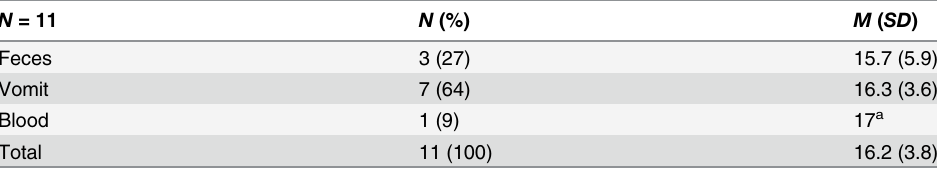
Table 1. Participants ’ disgust